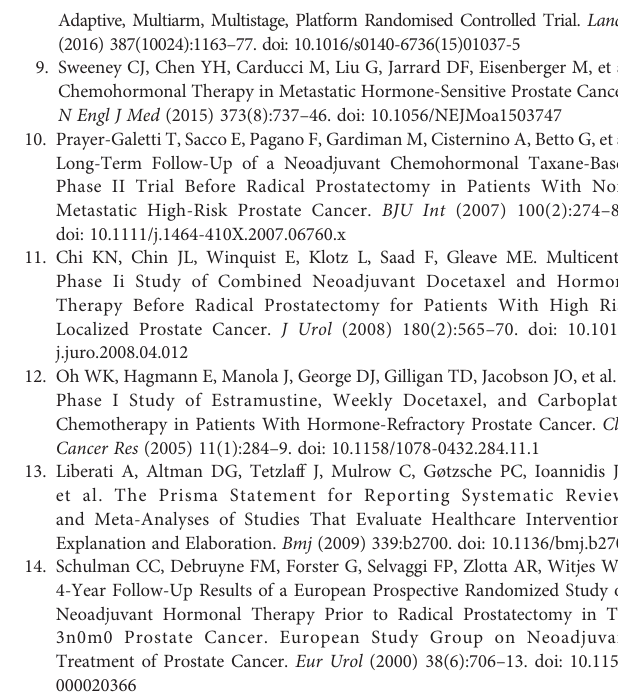
Supplementary Figure 1 | Risk of bias and risk of bias summary for included randomized controlled trials. Supplementary Figure 2 | Sensitivity analysis of pooled positive surgical margin (A) , pathological downstaging (B) , lymph node involvement (C) , and biochemical recurrence-free survival (D) . Supplementary Figure 3 | Funnel plot of the studies for positive surgical margin (A) , pathological downstaging (B) , lymph node involvement (C) , seminal vesicle invasion (D) , biochemical recurrence-free survival (E) , and overall survival (F)